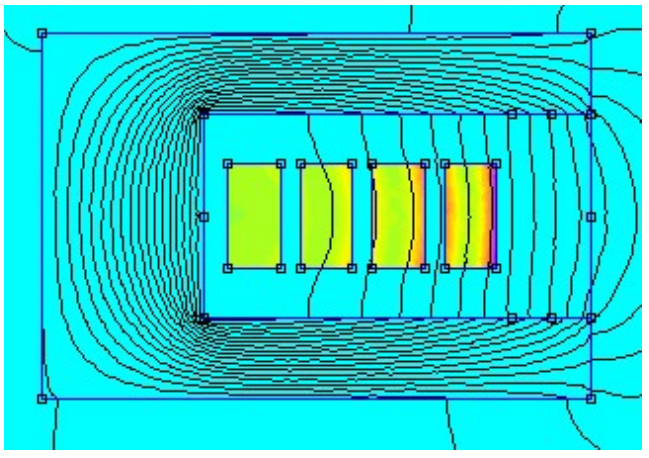
Figure 24. Current Density module—widest opening.